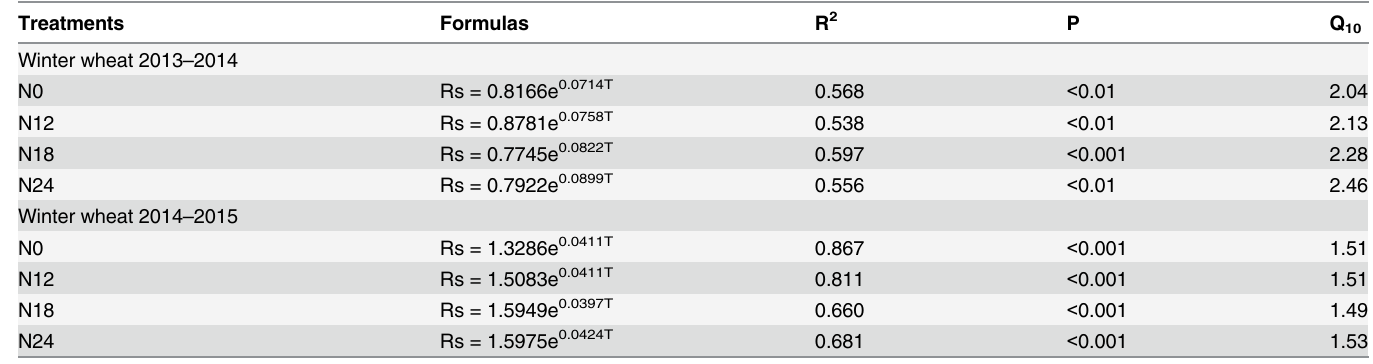
Table 2. The exponential relationship between soil respiration and temperature. Treatments